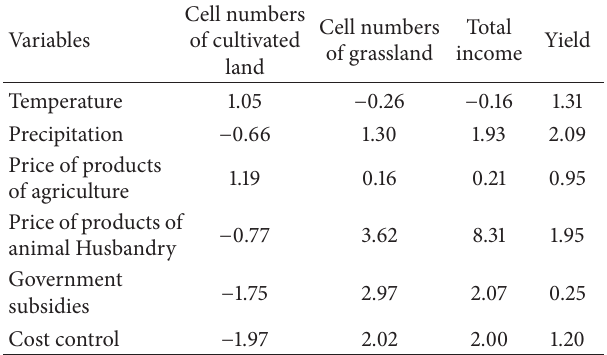
Table 2: Results of the sensitivity analysis, unit: